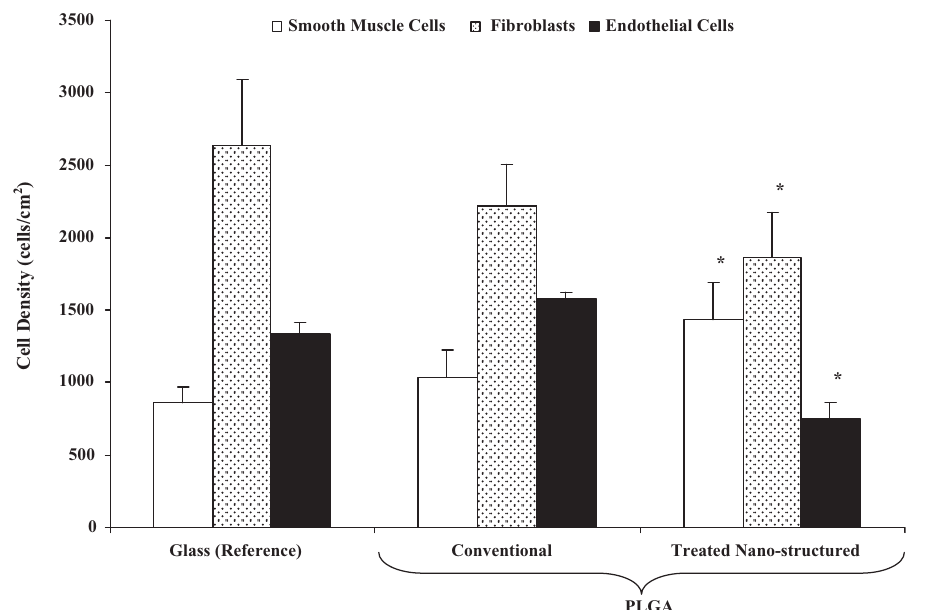
Figure 2 Endothelial cells, vascular smooth muscle cells, and fibroblasts show results that indicate, compared to untreated conventional PLGA, vascular smooth muscle cell adhesion was enhanced while endothelial cell and fibroblast density was significantly decreased on NaOH-treated nano-structured PLGA after 4 h.